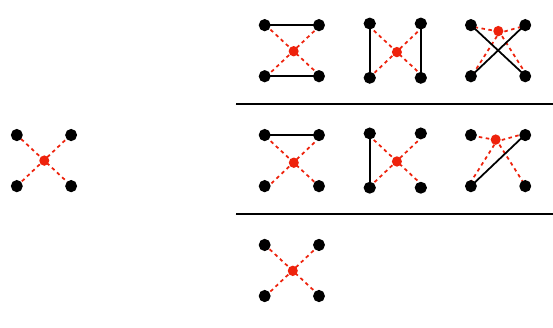
Figure 3 . Parity odd index structures of 4-photon and 4-graviton scattering in D = 7 respectively. The " symbol is denoted by a red dot with D (cid:0) 3 e